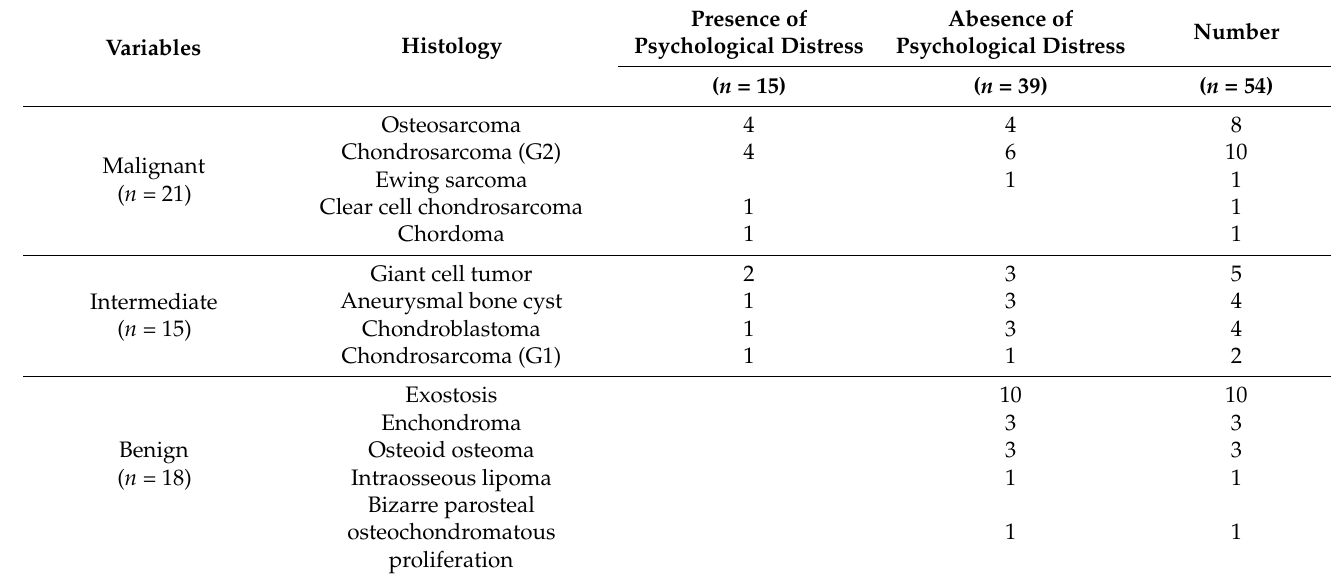
Table 2. Assessment of psychological distress in patients with bone